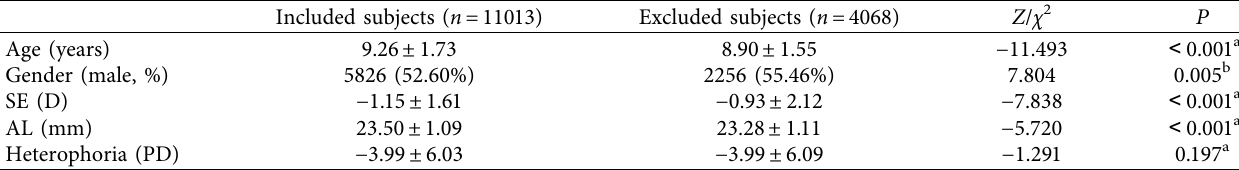
Table 1: Basic demographic parameters between different